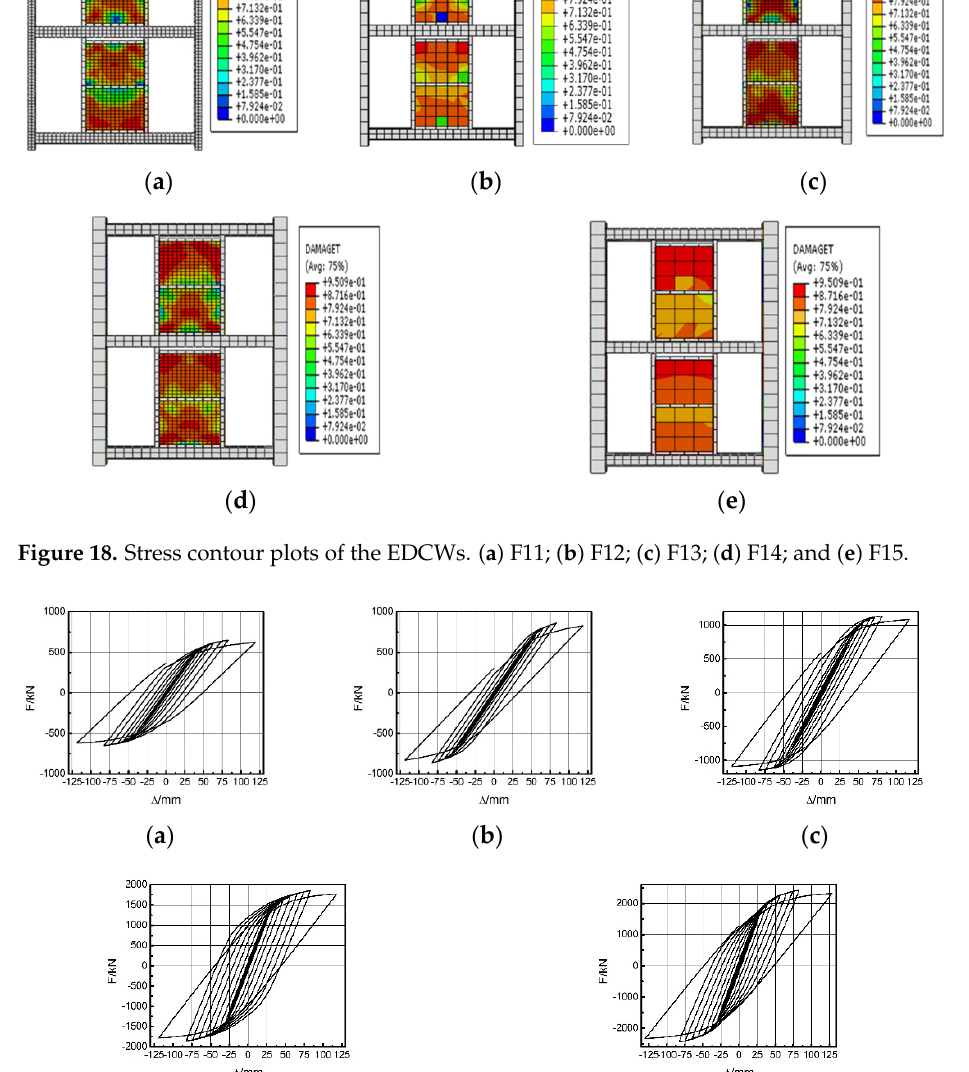
Figure 19. Hysteresis curves of the third group of frames: ( a ) F11; ( b ) F12; ( c ) F13; ( d ) F14; and ( e ) F15. Table 7. Cumulative dissipated energies of the